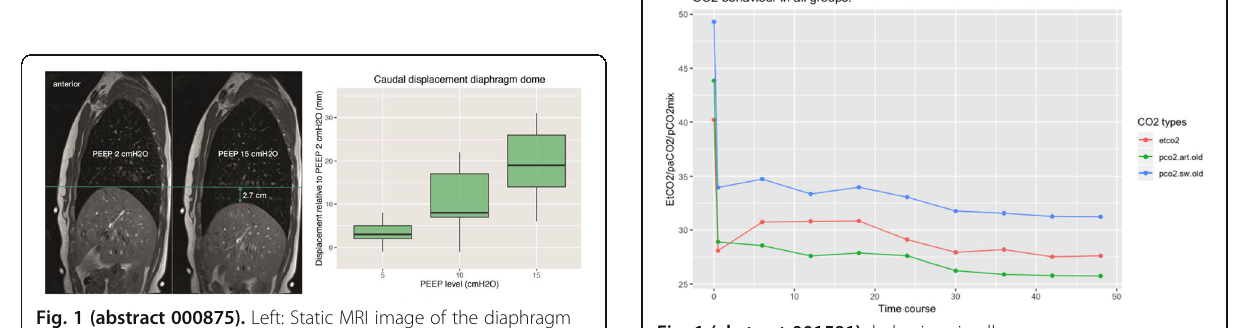
Fig. 1 (abstract 001591). behaviour in all groups.